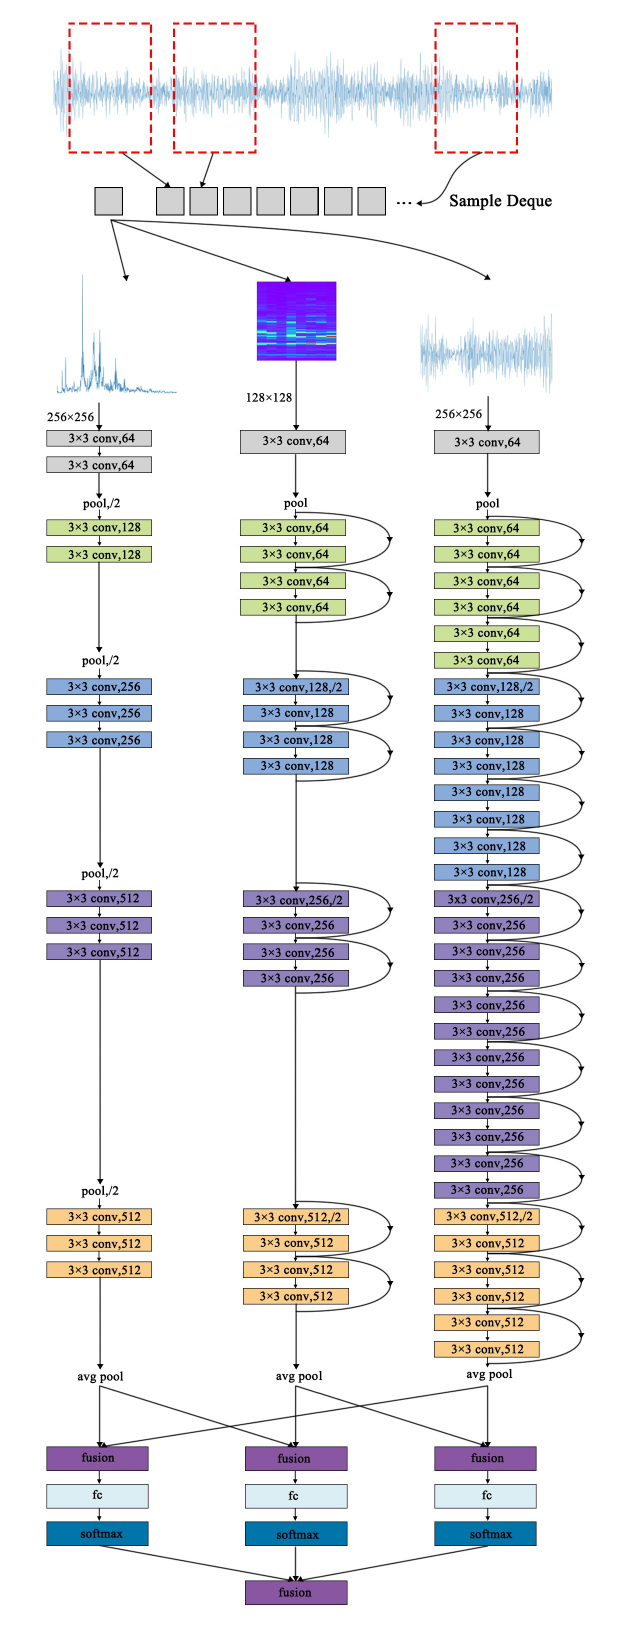
Figure 7. Structure of the final proposed